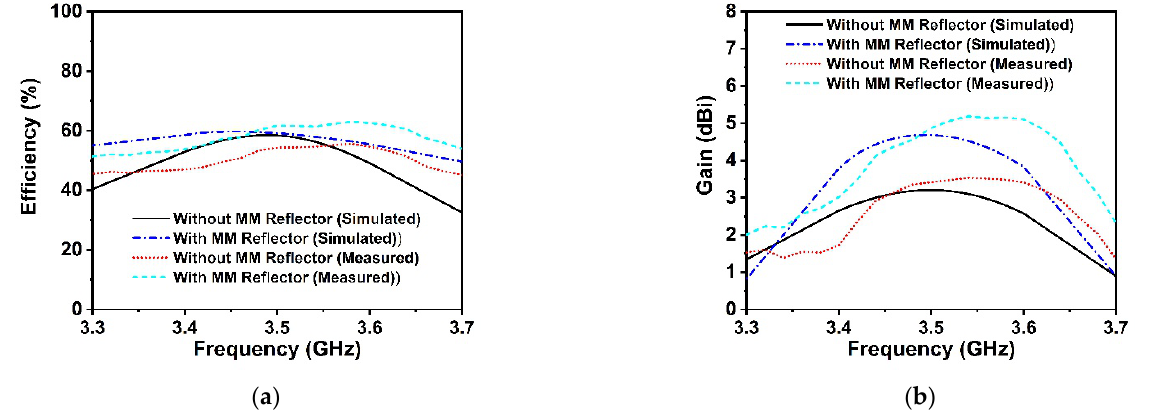
Figure 22. Comparison of ( a ) efficiency and ( b ) gain of the developed antenna with and without MM reflector.